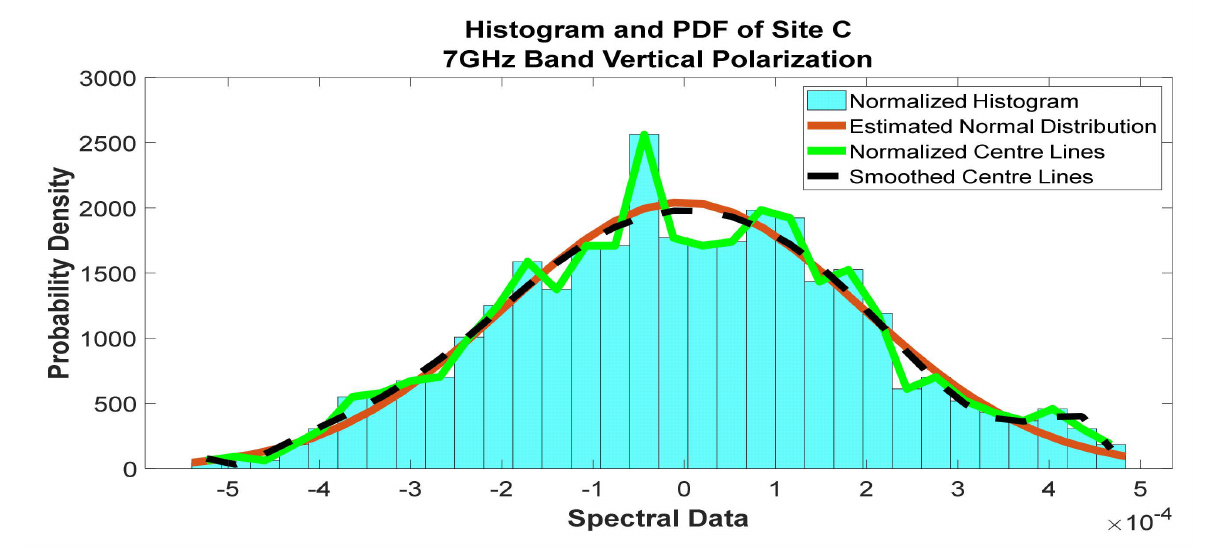
Figure 25. Histogram and PDF of the frequency scan for site C at 7 GHz vertical polarization.